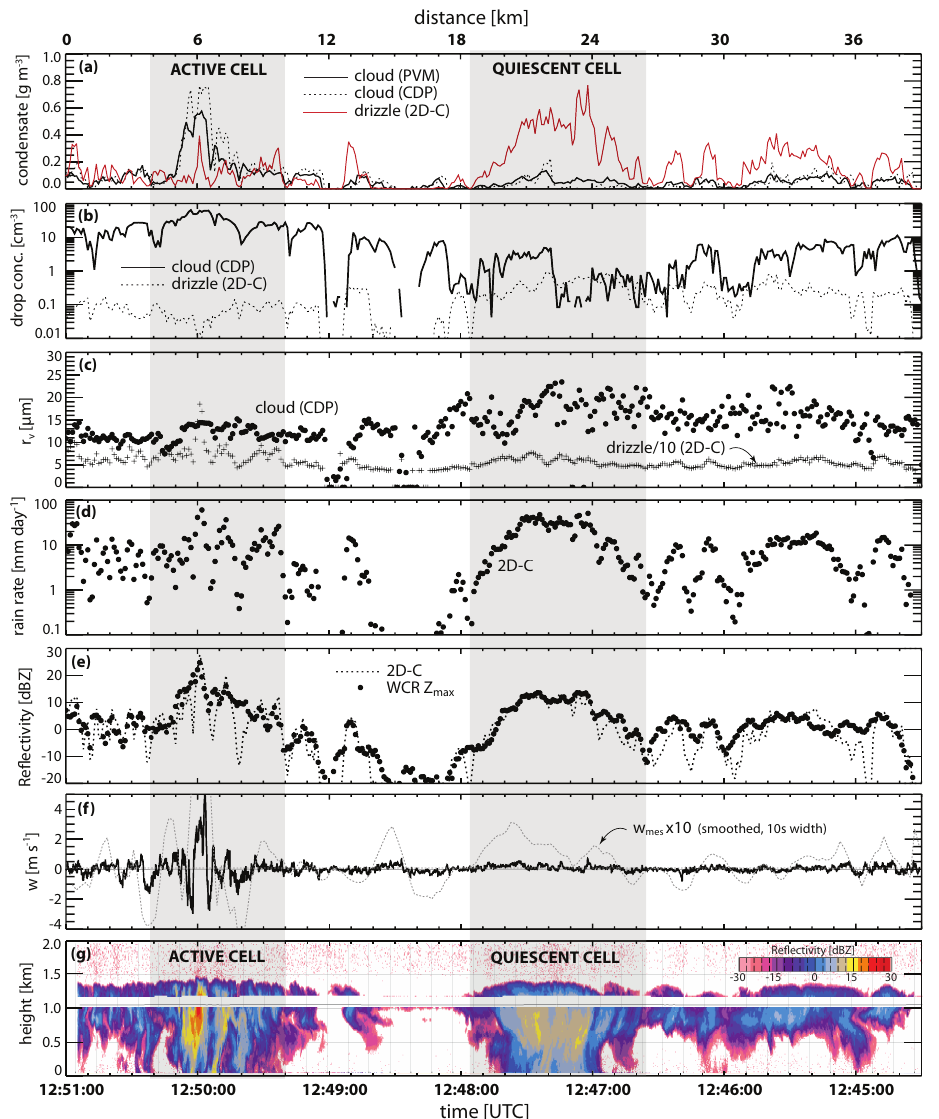
Fig. 22. Time series for 6.5 min ( ∼ 40 km) from leg C2 of RF06 at an altitude of 1084 m contrasting two cells producing strong drizzle. The panels show: (a) Condensed water content for cloud water (both from the PVM and the CDP) and drizzle (2-D-C); (b) cloud droplet and drizzle droplet concentration; (c) mean volume radius for cloud (CDP) and drizzle (2-D-C), note that value for drizzle is divided by 10 to facilitate use of same ordinate; (d) precipitation rate from the 2-D-C; (e) column maximum radar reflectivity Z max from the WCR, and in-situ derived radar reflectivity from the 2-D-C; (f) vertical wind component (solid, 25 Hz) and “mesoscale” vertical wind w mes smoothed with a 10 s boxcar filter (dotted) and magnified by a factor of 10; (g) radar reflectivity cross section from the WCR. The gray regions indicate the approximate locations of an active (left) and a quiescent (right) cell (see text).